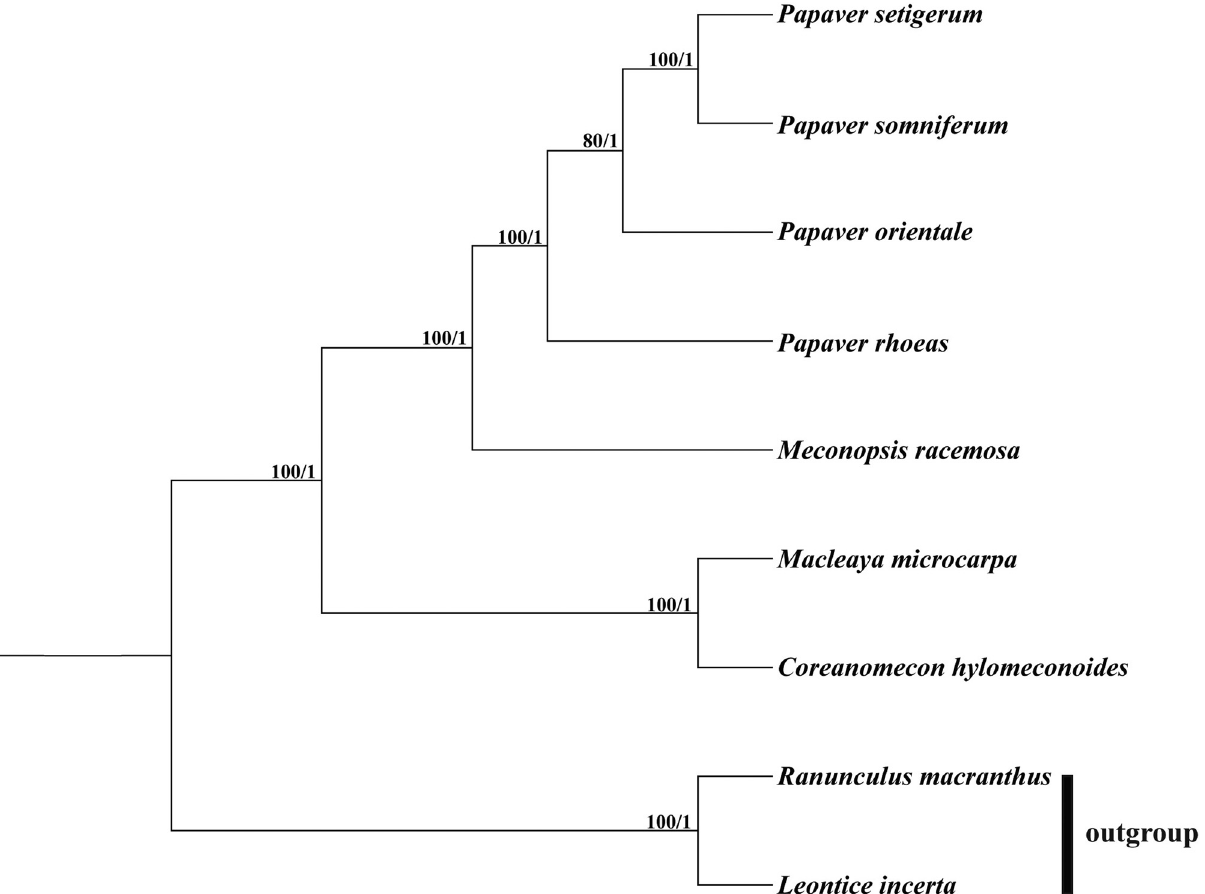
Figure 6 - Phylogenetic tree reconstruction of Papaveraceae using maximum likelihood (ML) based on whole chloroplast genome sequences. Numbers above the branches represent bootstrap values from maximum likelihood analyses and posterior probabilities from Bayesian inference,